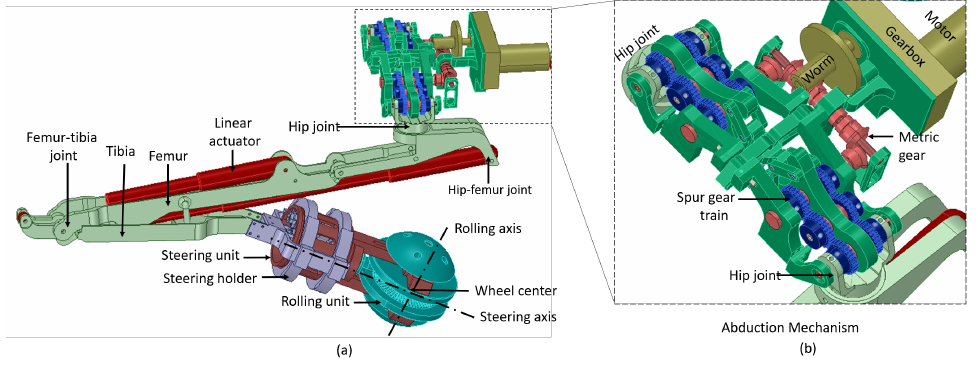
Figure 3. A CAD model of the Tarantula-II Platform showing ( a ) the leg and wheel and ( b ) the simultaneous abduction